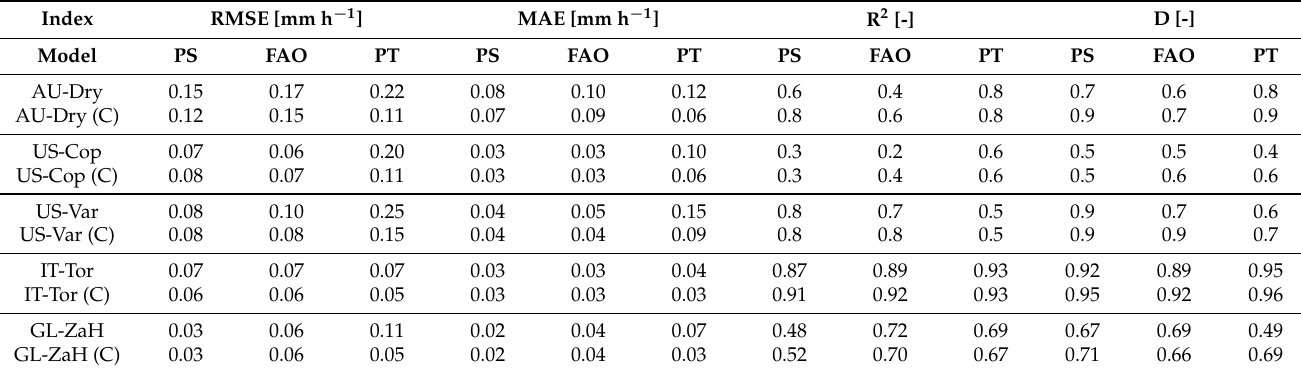
Table 4. Hourly values of GOFs obtained for each site and for the uncalibrated and calibrated (C) cases.